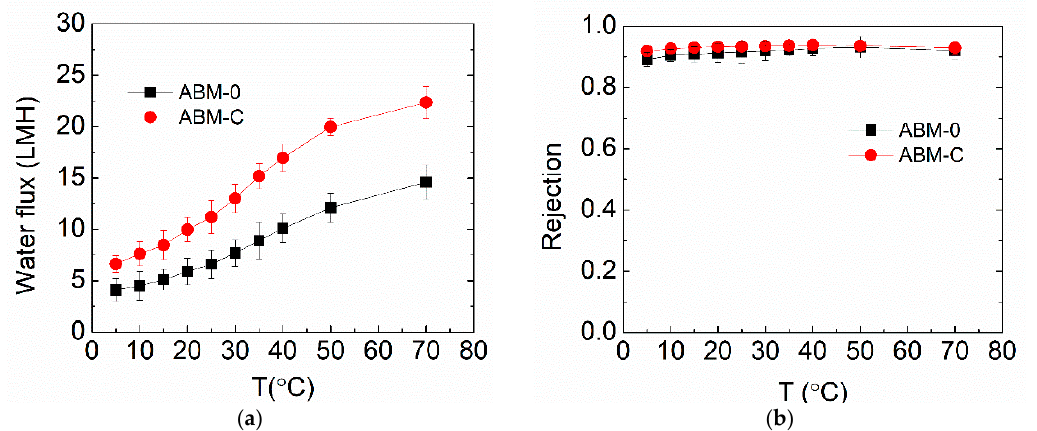
Figure 6. Effects of operation temperature on ( a ) water flux and ( b ) salt rejection of the ABM-C and ABM-0 membranes. The molar ratio of cholesterol in the proteoliposome was 30 % and the concentration of proteoliposomes in the MPD solution was 0.016 wt/wt% for all AqpZ-containing membranes. All tests were performed at 5 bar, with 10 mM NaCl solution as a feed solution. The error bars were derived from results for 2 independent membrane samples.